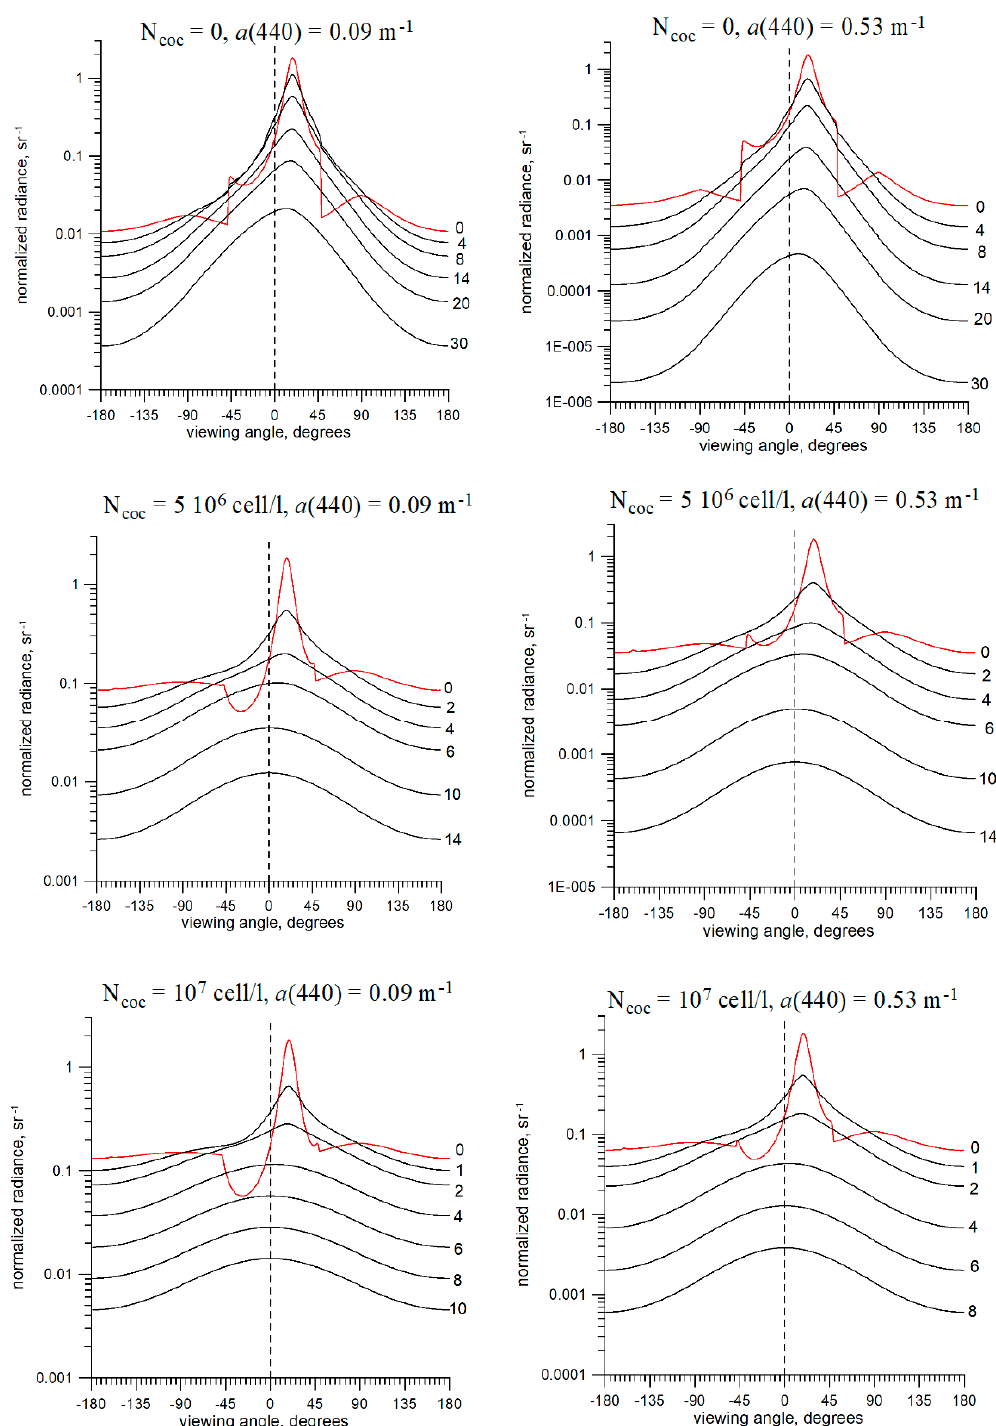
Figure 4. Black Sea. The radiance distributions in the plane of the sun as a function of the viewing angle θ (the range of positive values of θ corresponds to the azimuthal viewing angle ϕ = 0°, the negative values ϕ = 180°; the downward radiance in the θ range of and − 90° ÷ +90°, the upward radiances − 180° ÷ ( − 90°) and 90° ÷ 180°). The left part shows the absorption a (440) = 0.09 m − 1 , the right, a (440) = 0.53 m − 1 . The numbers near the curves show the depth in meters. For θ 0 = 25°, λ = 530 nm, wind speed 0 m/s.